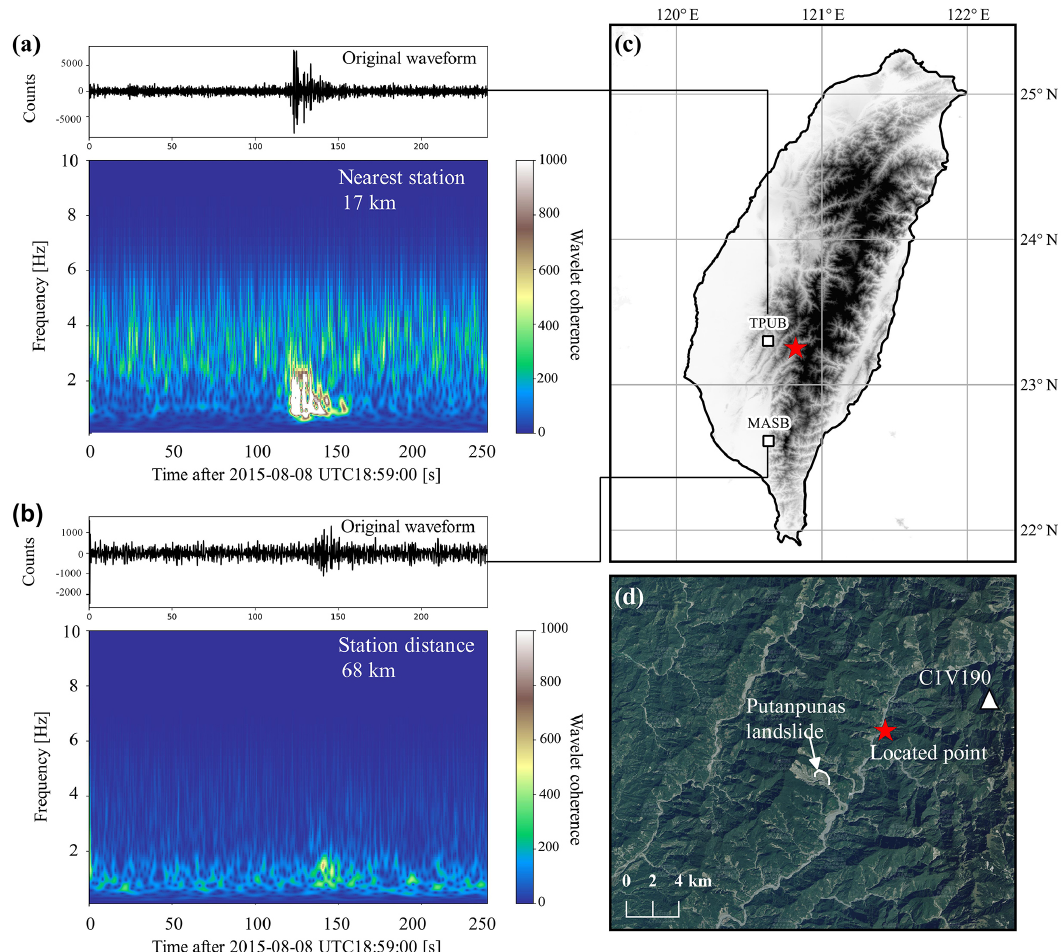
Figure 7. Characteristic triangular signature visible in a spectrogram within a time window starting at 18:59UTC and ending at 19:03UTC on 8 August 2015. (a) Original waveform and spectrogram of the vertical component at station TPUB. (b) Original waveform and spectrogram of the vertical component at station MASB. (c) Distribution of located point (red star) and these two seismic stations. (d) The located point and the landslide site. The distance error between the location result and the landslide site is